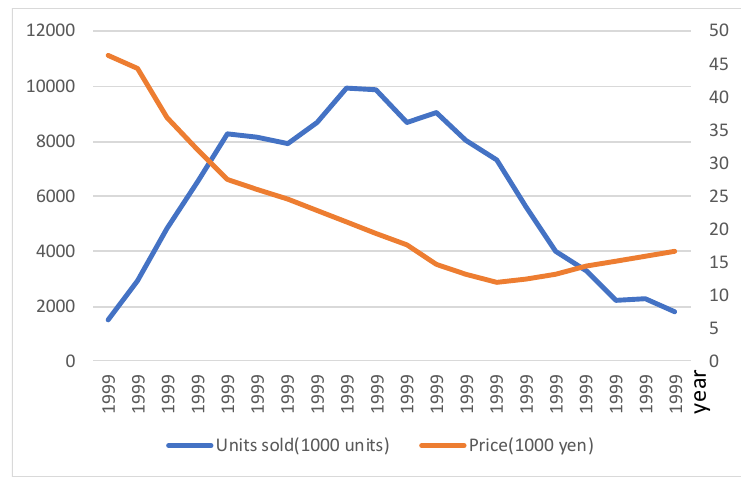
Figure 2. Units sold and price of compact digital